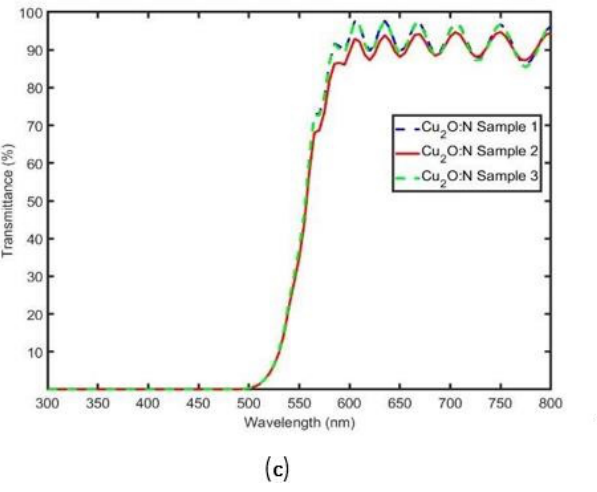
Figure 19. ( a ) Reflectance, ( b ) absorbance, and ( c ) transmittance as a function of wavelength for the metal oxide structure [100].